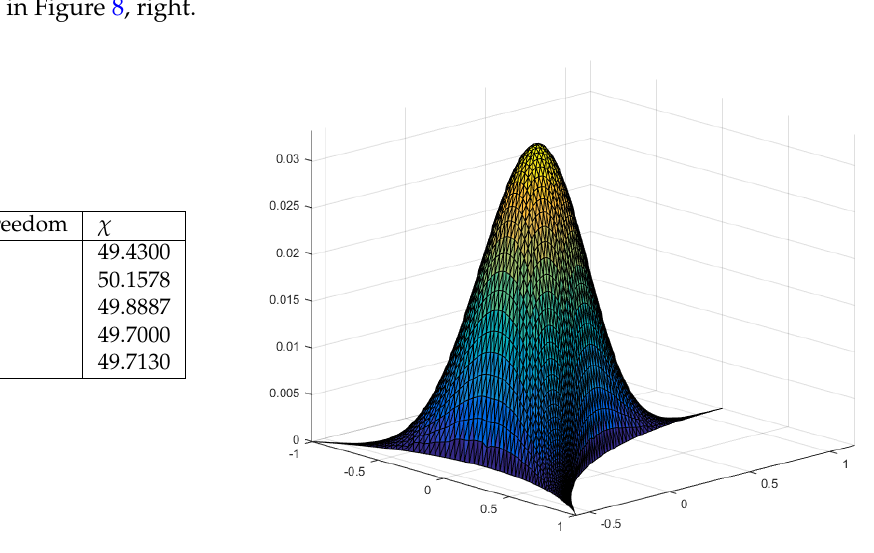
Figure 8. ( left ) Table of area independent parameter χ against degrees of freedom in the FEA model; ( right ) Numerically computed velocity profile of flow through a curvilinear triangle with area A p